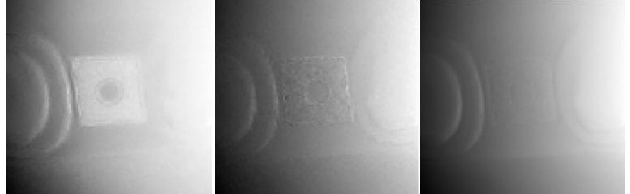
Figure 3. Phase maps of a dark target with 3 shifts (left), 5 shifts (middle) and 10 shifts